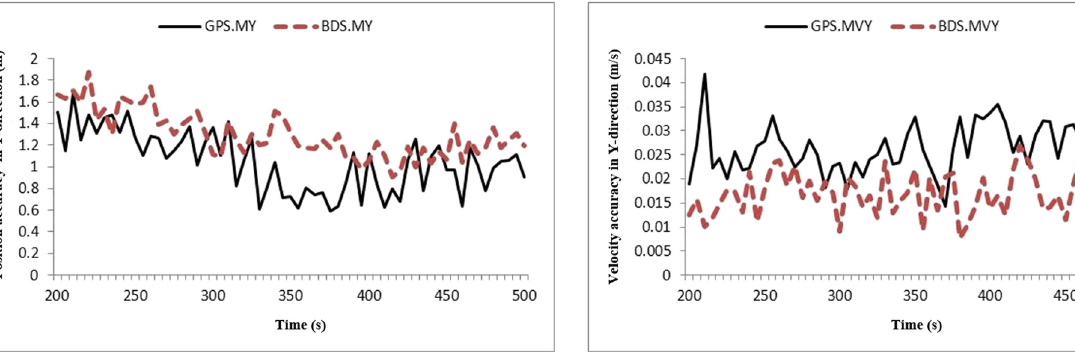
Figure 8: Velocity precision of on - board BDS and GPS in Y - direction.